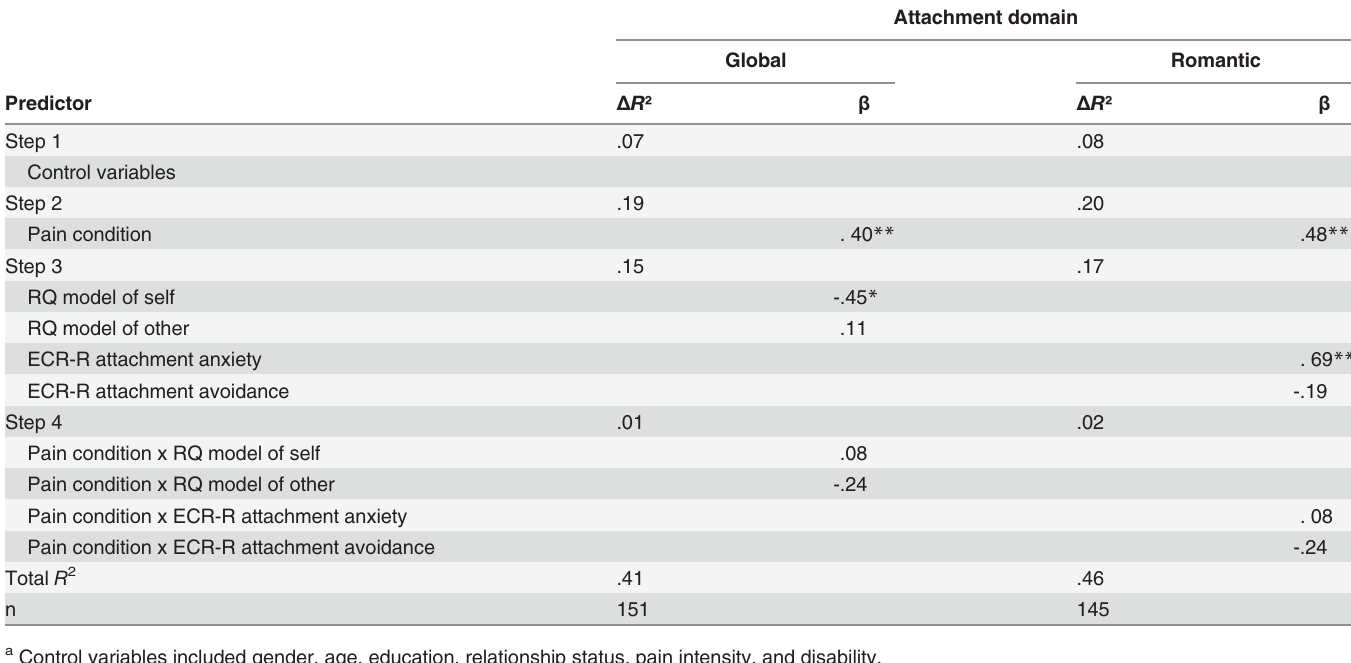
Table 7. Regression analyses predicting depression from pain condition, attachment dimensions, and interaction between pain condition and at- tachment